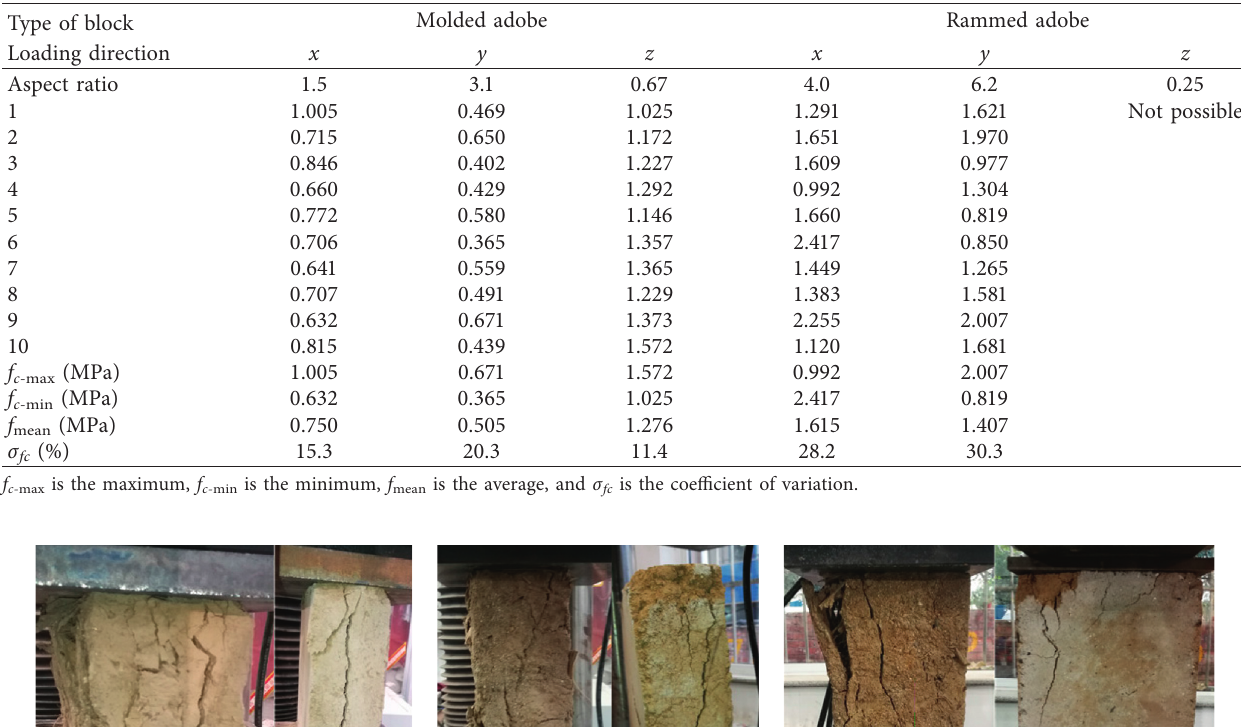
Table 4: Comparison of the compressive strength of full-size blocks for different load directions.